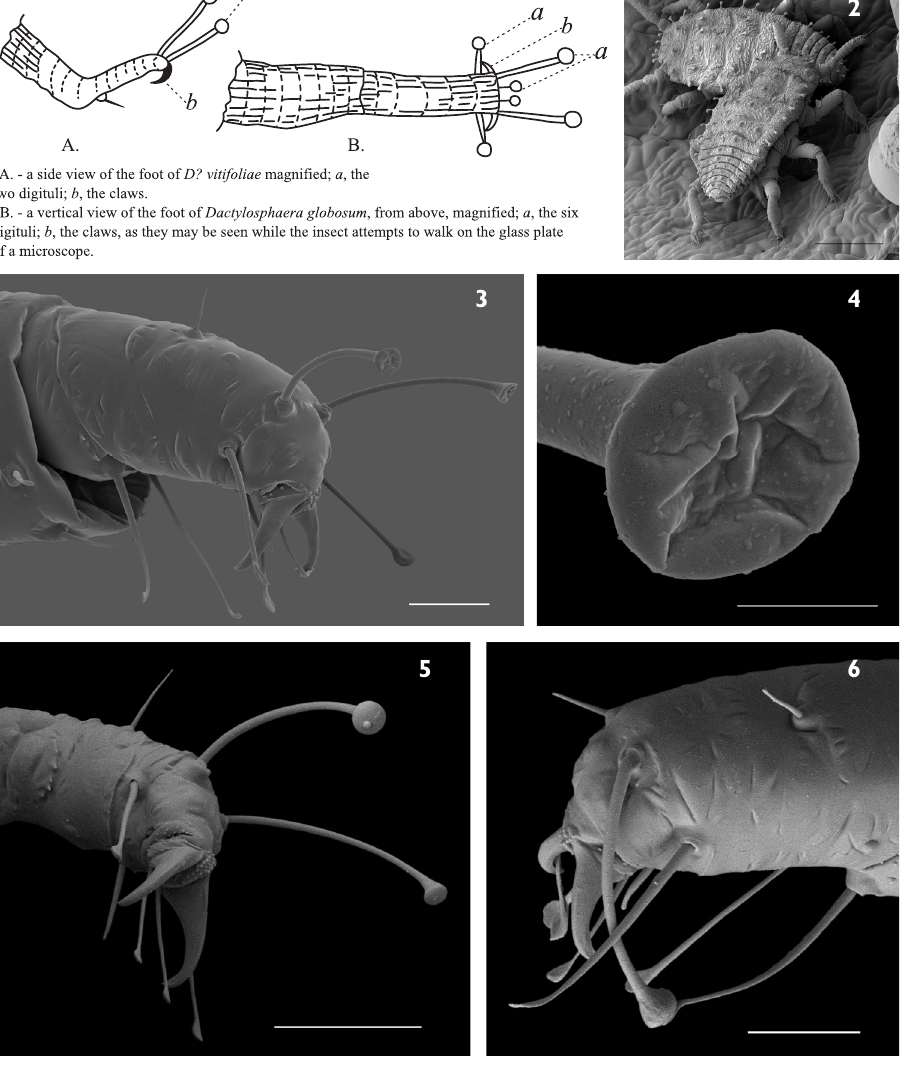
Figure 1–6. 1 Reproduction of Shimer’s (1867a) original illustration indicating what he considered digitules 2 Phylloxera in situ showing leg and feet position 3 Hind leg of Phylloxera showing all digitules 4 Close up of dorsal digitule from Figure 3. Note how the ventral surface appears membranous and col- lapsed 5 Hind leg of Phylloxera showing dorsal digitules with expanded ventral surfaces 6 Front left leg of Phylloxera showing anterior seta is not a digitule. Scale bar 10 μm. Scale bars: ( 2, 6 )100 μm; ( 3 ) 10 μm; ( 4 ) 2 μm; ( 5 ) 20